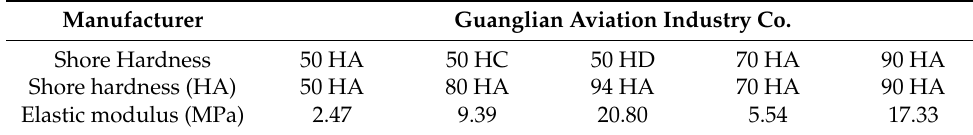
Table 3. Elastic modulus corresponding to bladder of different